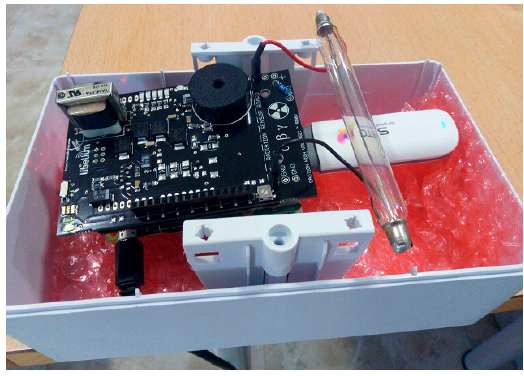
Figure 6. Cover case including device.